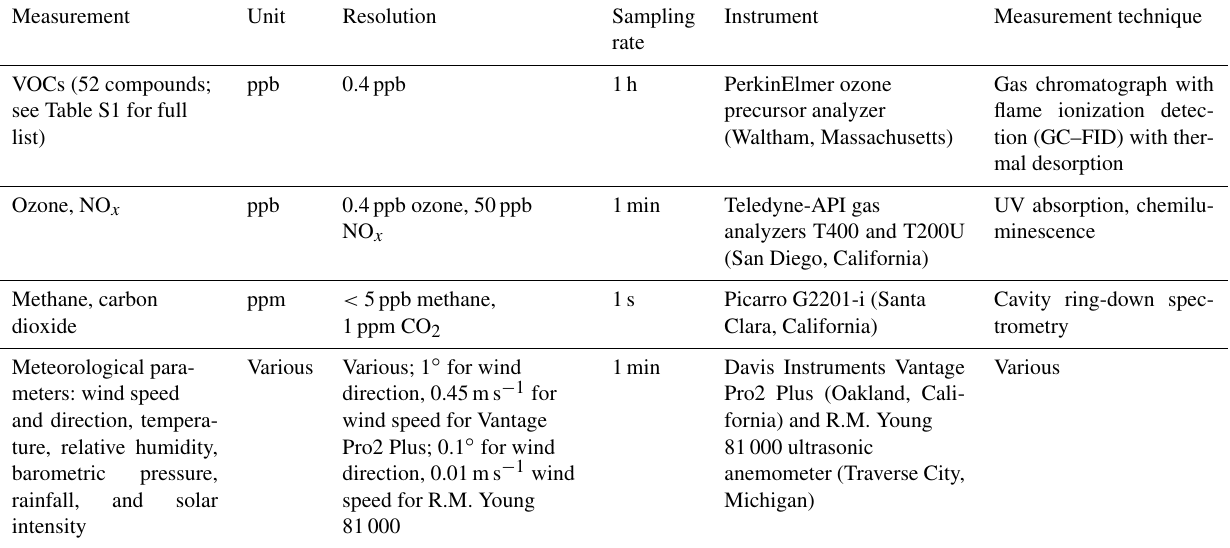
Table 1. Constituents measured by the MSEEL mobile air monitoring laboratory (Pekney et al., 2018).